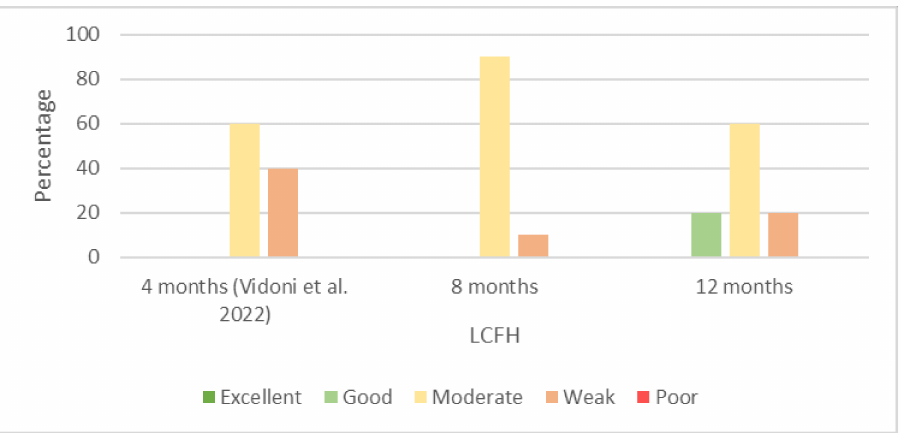
Figure 3. Percentages of results of interobserver agreements (Cohen’s kappa coefficient) for location of center of femoral head (LCFH) at 4 [29], 8, and 12 months of